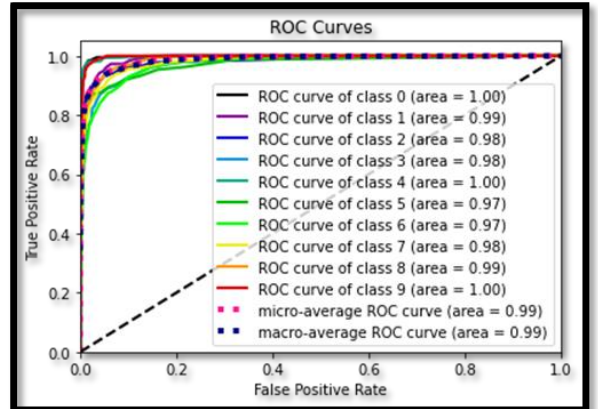
Fig. 5 . ROC for tomato